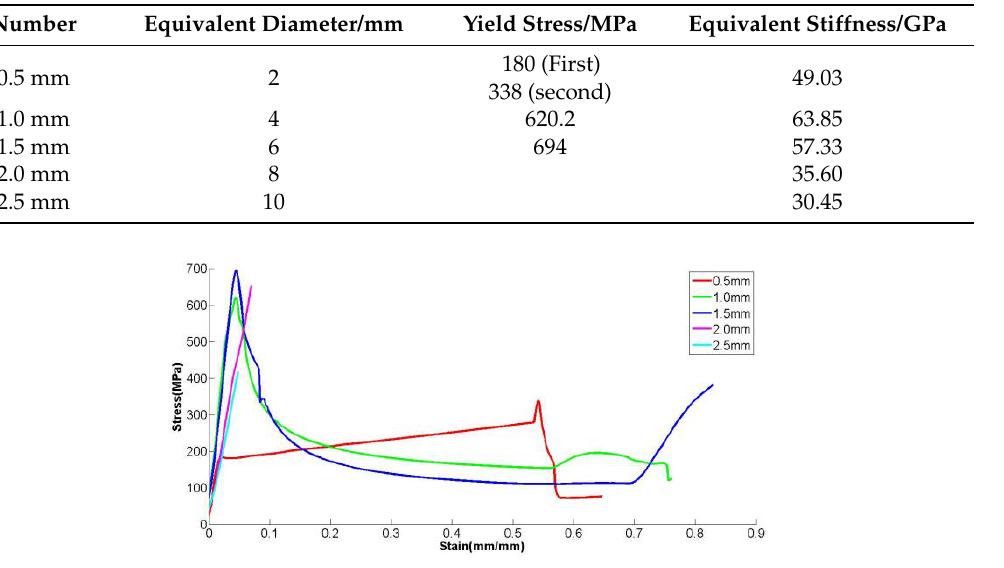
Figure 27. Compression curves of different sized samples.